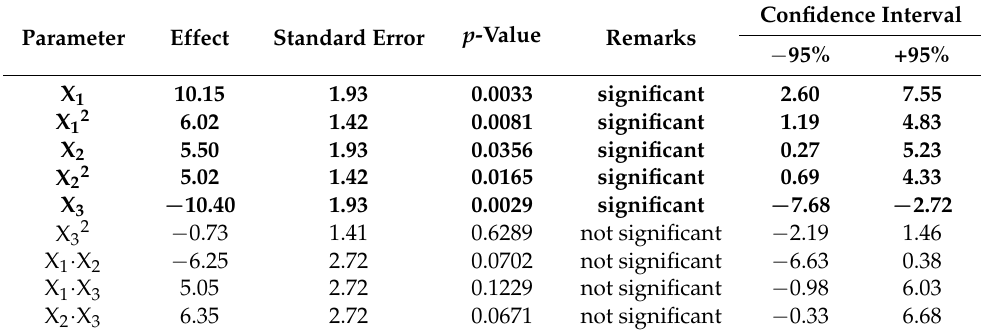
Table 4. Effect estimates for the effectiveness of caking prevention of fertilizers after 30 days of storage (Y 2